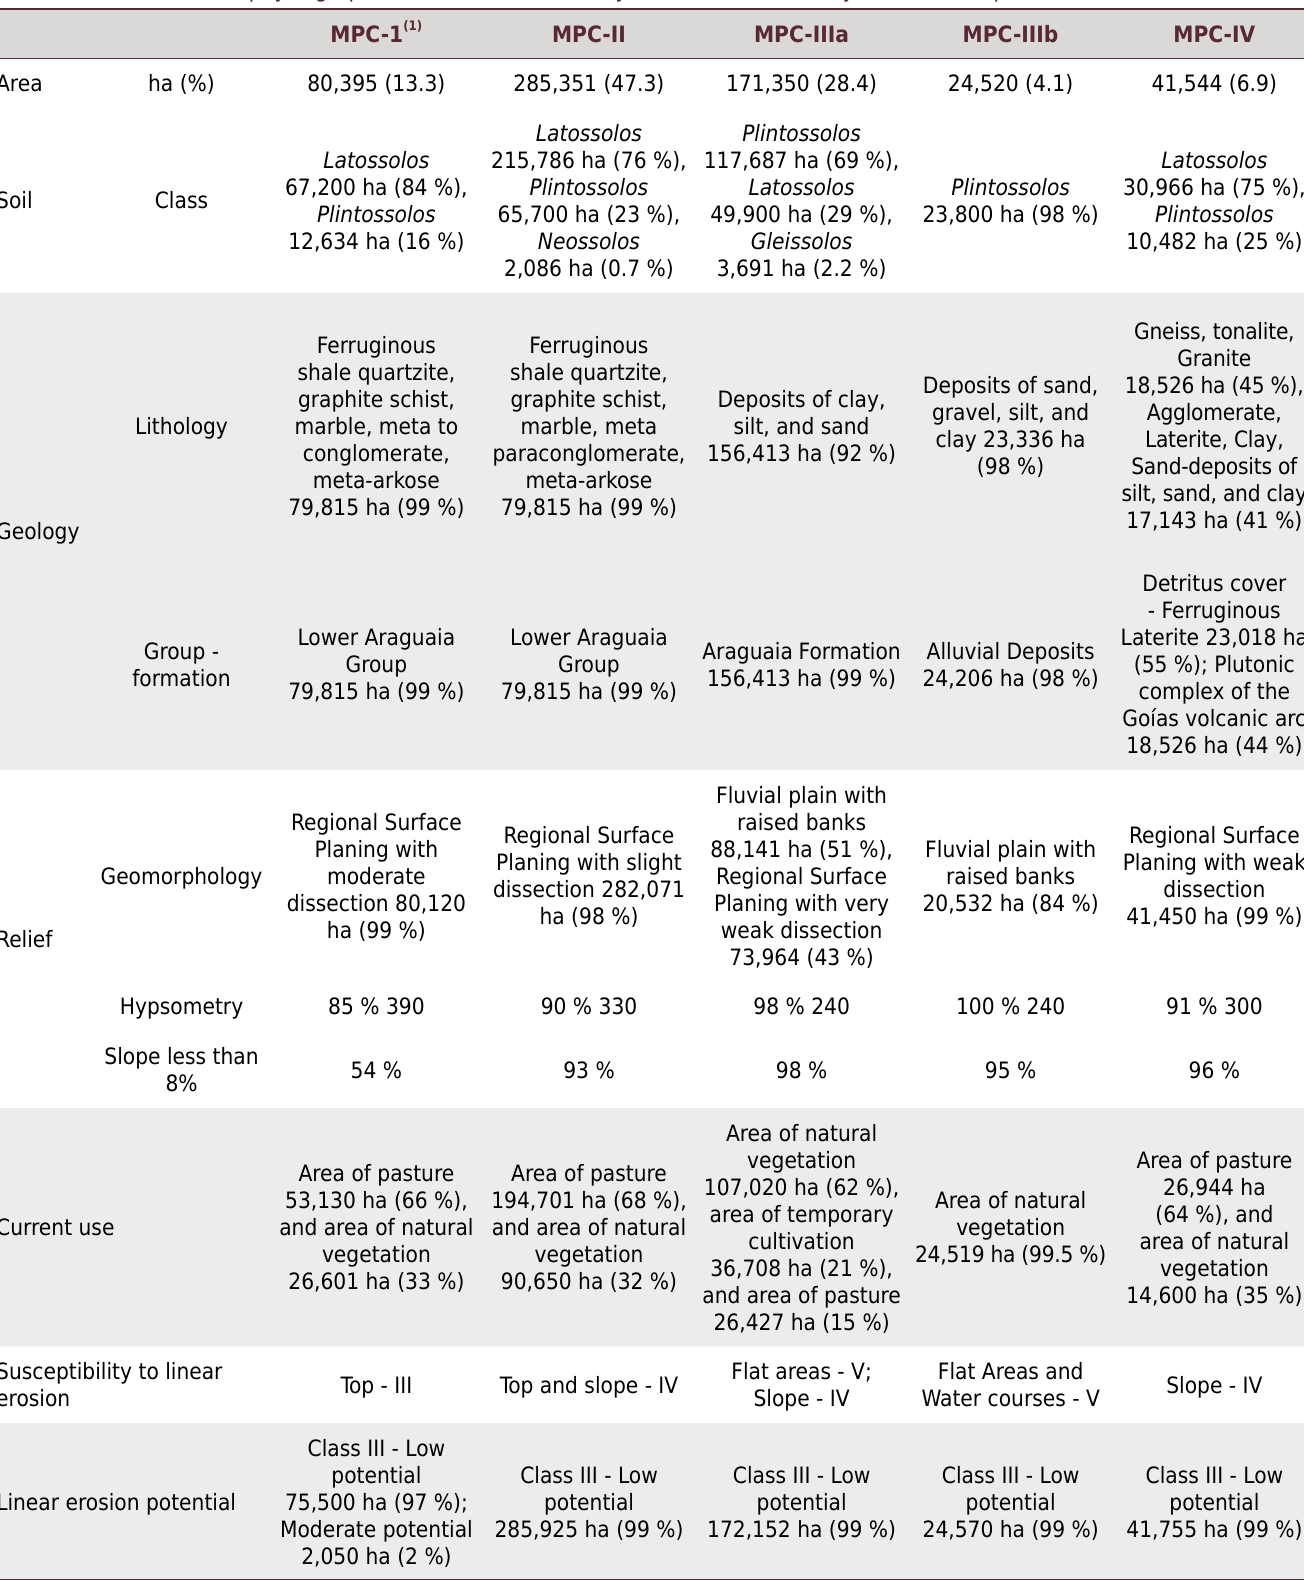
Table 9. Overview of the physiographic features and summary of the results of analysis of erosive potential in the Cerrado